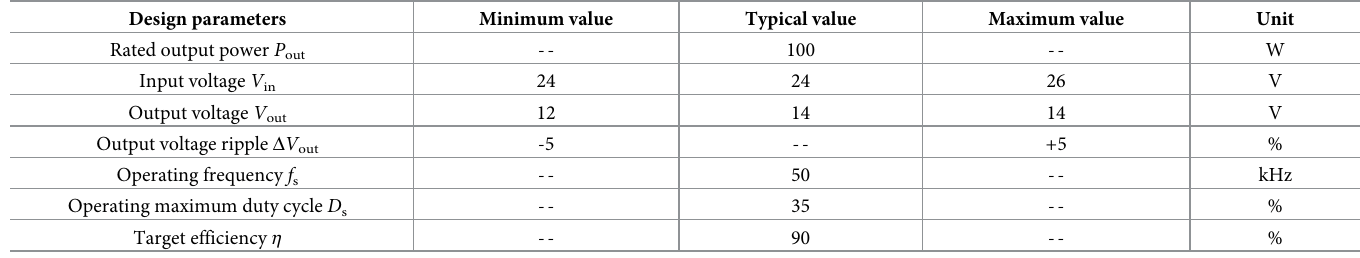
Table 3. Design parameters of Full-Bridge DC/DC converter. Design